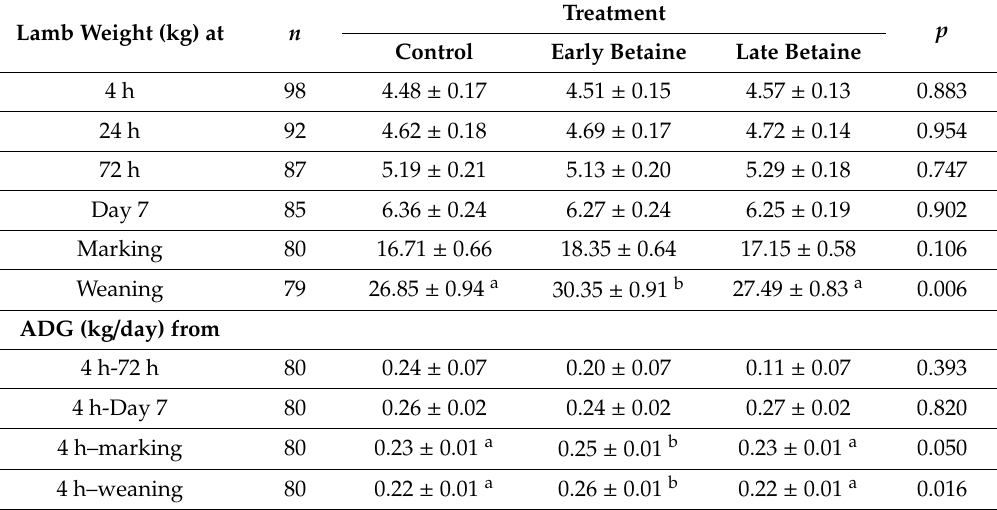
Table 3. Lamb weight at 4 h, 24 h, 72 h, Day 7 post-partum, marking (53.2 ± 0.2 days of age) and weaning (99.3 ± 0.2 days of age); and average daily gain (ADG) from 4 h to 72 h, 4 h to Day 7, 4 h to marking and 4 h to weaning (Estimated marginal means ± SEM). Values with di ff ering superscripts vary significantly ( p < 0.05).